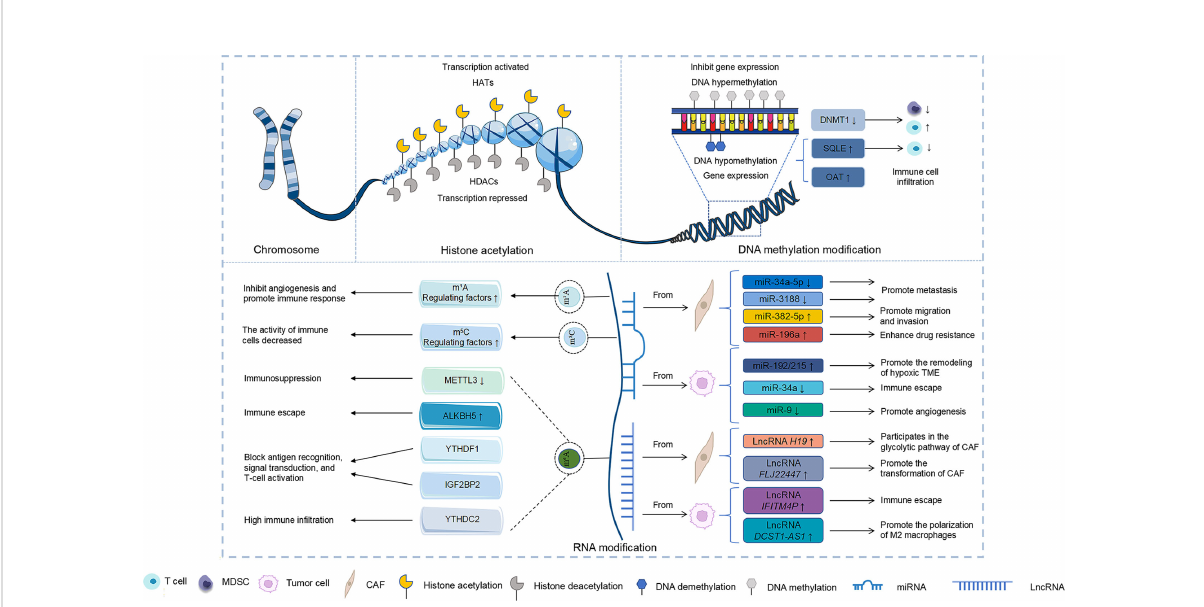
FIGURE 2 Effect of epigenetic modi fi cations on the TME of head and neck tumours. DNA methylation, RNA modi fi cation, and ncRNA modi fi cation resulted in different gene expression changes that affected the TME of head and neck